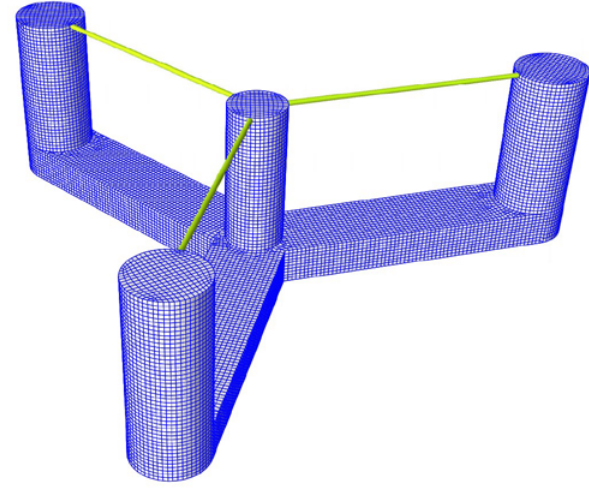
Figure 5. Image of Model 1.